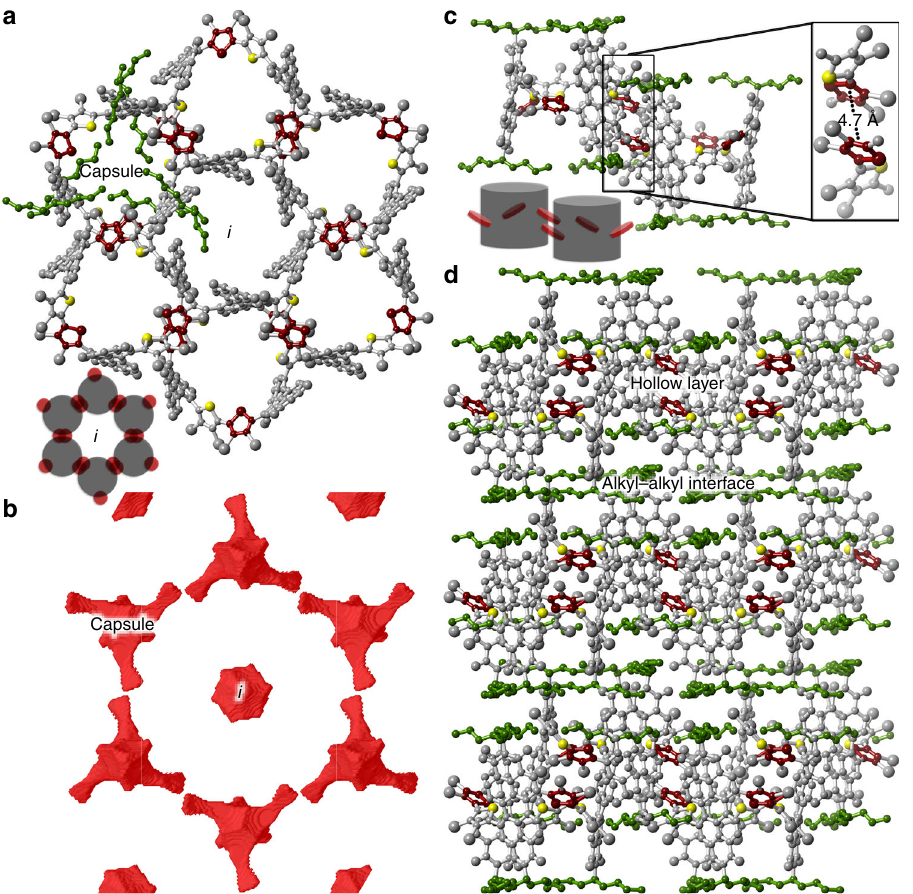
Fig. 3 Structural packing of 1 -Br 12 . a View of the honeycomb structure in the ab plane for 1 -Br 12 . The capsule and i corresponds to the internal cavity of 1 - Br 12 and the cavity formed by the packing of 1 -Br 12 , respectively. The remaining sulfur atoms are colored in yellow to provide a marker to identify the macrocycle cavities. See bottom left cartoon. Highlighted in green are the imide side chains (some of the sidechains have been removed to clarify the view of the cavity). In red are the thiophene rings likely involved in holding the macrocycles together. b Surface map of the void space in the ab plane of 1 -Br 12 . c Two molecules of 1 -Br 12 where the thiophene-to-thiophene interaction is highlighted as an inset. Bottom left cartoon represents this interaction. d View of the packing of 1 -Br 12 . As shown, the vertical stacking follows the c axis. The alkyl sidechains of the imide are shown in green. Hydrogen atoms have been removed from all structures to clarify the